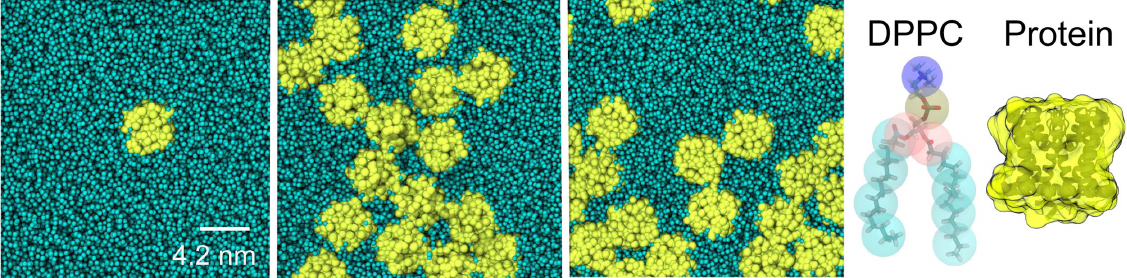
FIG. 1. Snapshots of the membrane systems at the end of the respective simulations runs. From left to right: (i) protein-poor membrane composed of 2045 DPPC phospholipids and a single NaK channel protein; (ii) protein-rich membrane system composed of 1600 DPPC lipids and 16 NaK proteins: aggregating system; (iii) protein-rich membrane system composed of 1600 DLPC lipids and 16 NaK proteins: nonaggregating system; (iv) schematic structures of a DPPC phospholipid and a NaK channel protein employed in our coarse- grained simulations. For both DPPC and the NaK channel, the transparent coarse-grained structure is shown on top of the atomistic